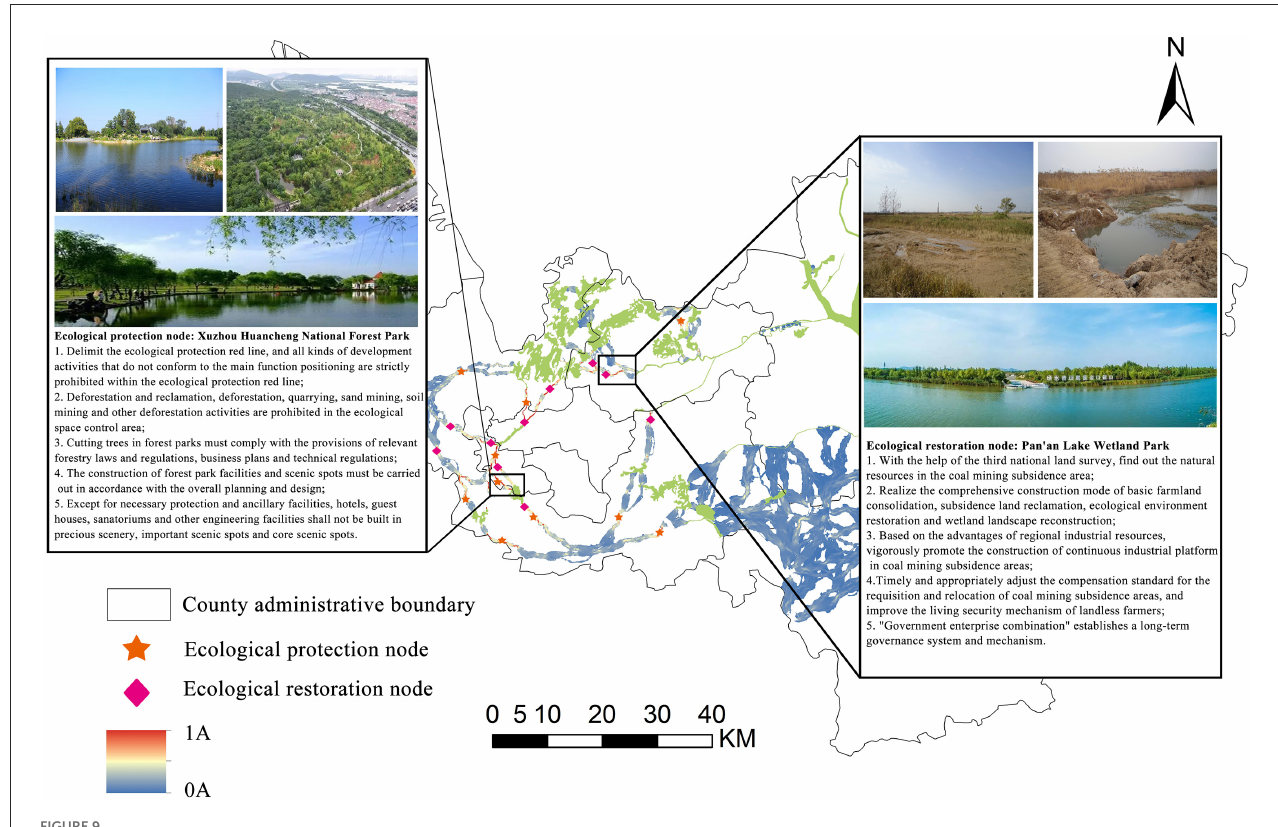
FIGURE9 Two cases of key ecological protection/restoration areas in